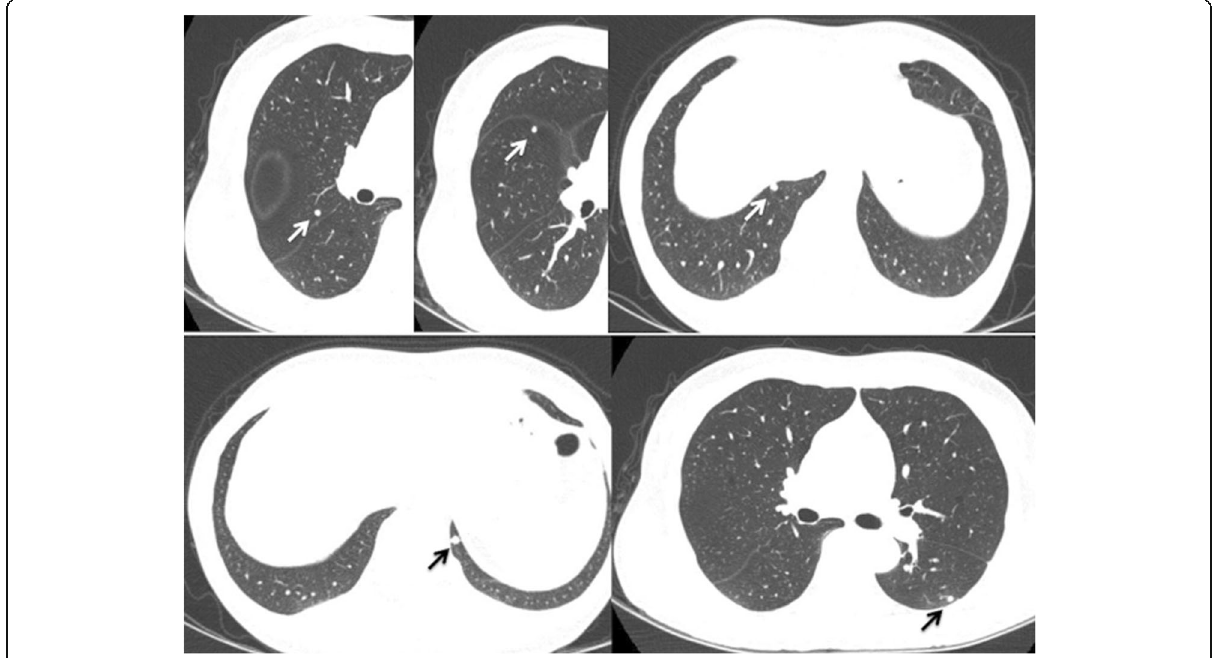
Fig. 2 Chest CT findings. Small pulmonary nodules located in S6 and S10 of the left lung and S2, S4, and S10 of the right